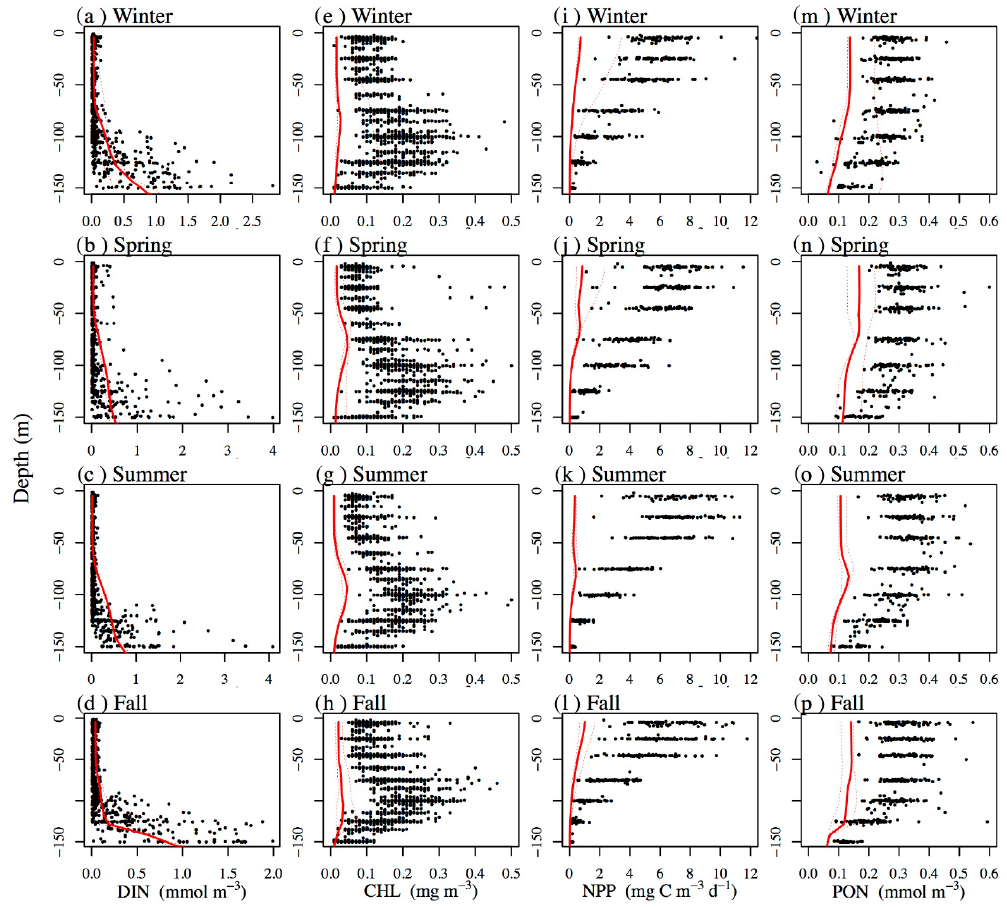
Figure 13. The same as Fig. 6, but for station